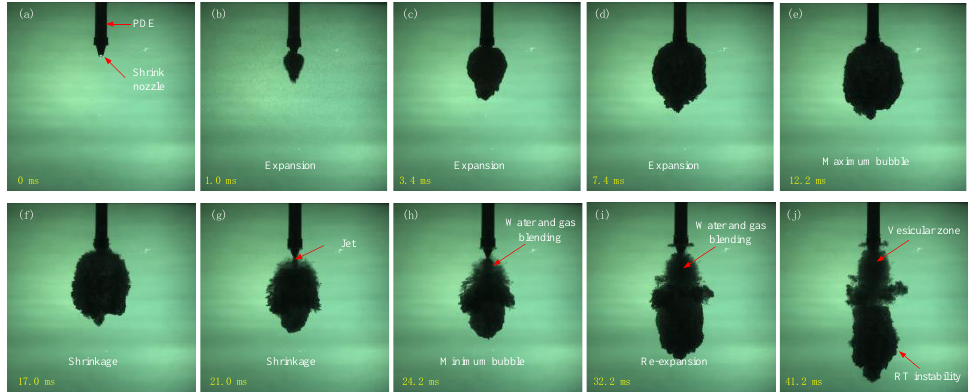
Figure 8. Bubble evolution when the shrinking nozzle is installed: ( a ) t = 0 ms, ( b ) t = 1.0 ms, ( c ) t = 3.4 ms, ( d ) t = 7.4 ms, ( e ) t = 12.2 ms, ( f ) t = 17.0 ms, ( g ) t = 21.0 ms, ( h ) t = 24.2 ms, ( i ) t = 32.2 ms, ( j ) t = 41.2 ms.